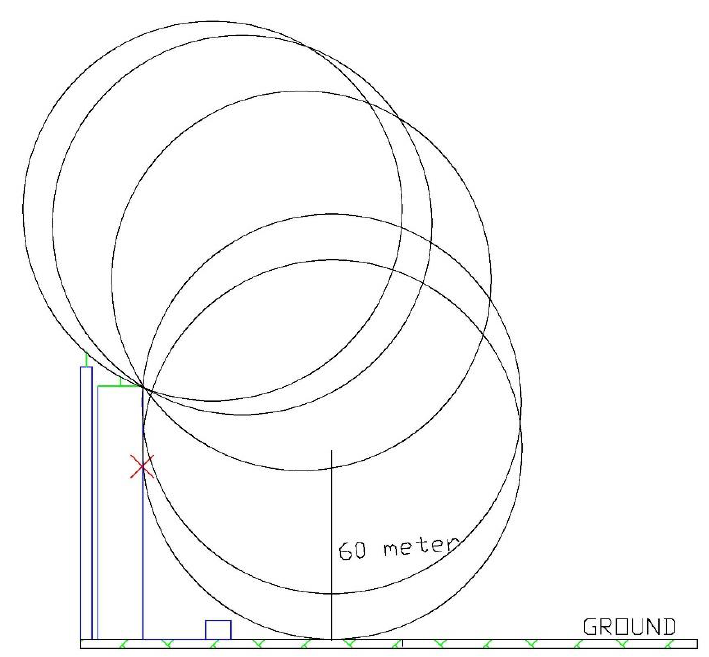
Figure 5. Design improvement of external LPS of the prilling tower.